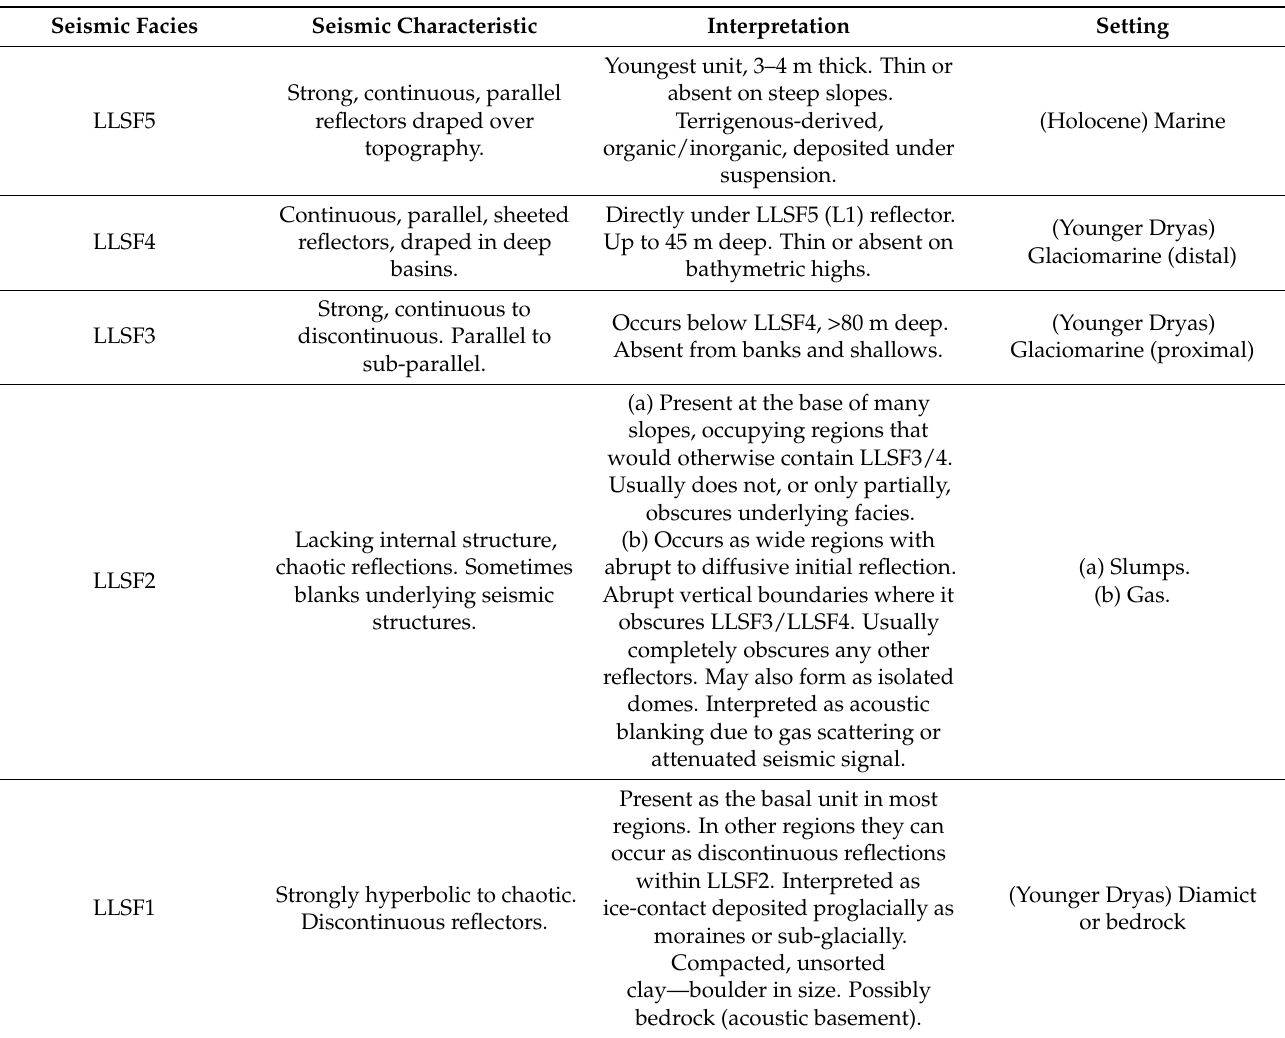
Table 1. Seismic facies of Loch Linnhe and their interpretations adapted from McIntyre